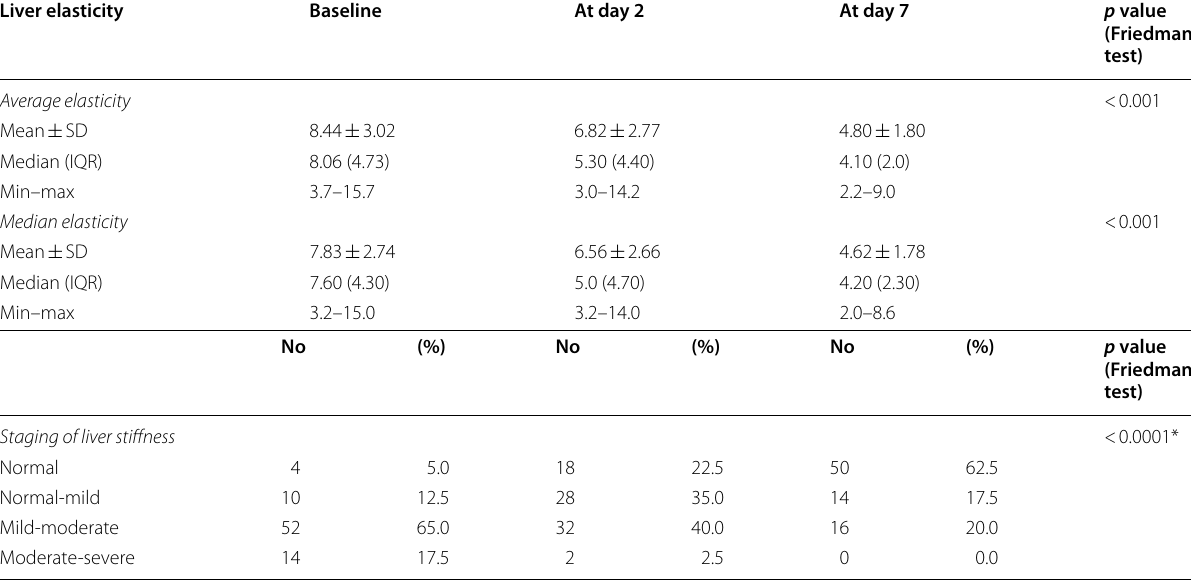
Table 3 Liver elasticity changes, measured before and after biliary